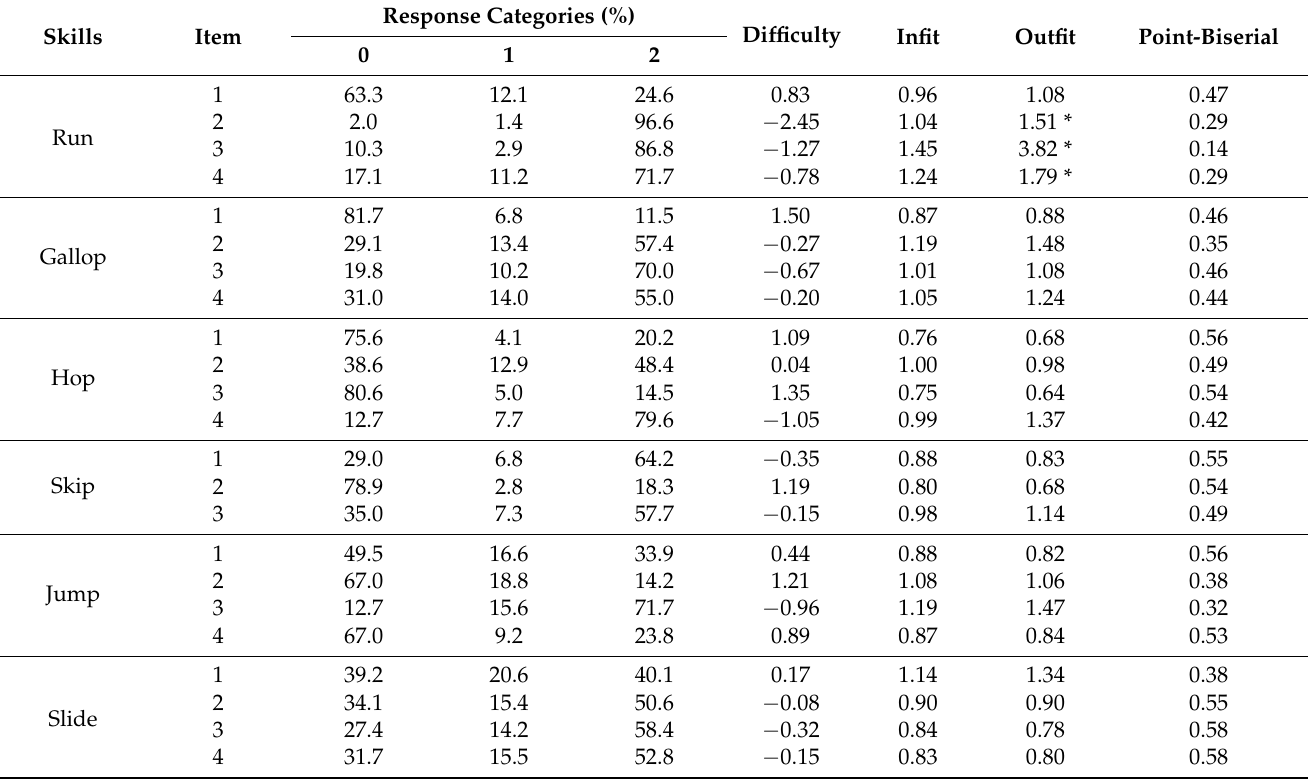
Table 2. Percentage of response, Item Difficulty, Infit and Outfit Indexes, and Point-Biserial Correla- tions with the Locomotor Skills Scale